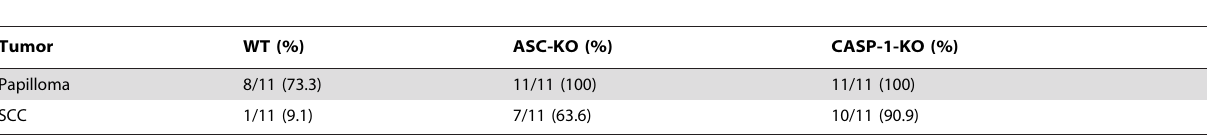
Table 1. Histologic analysis of tumors from wild type and inflammasome-deficient mice.